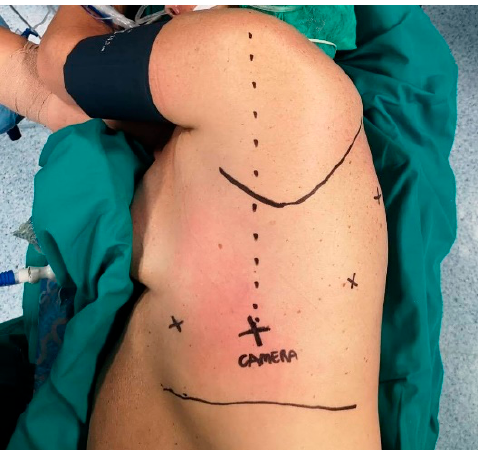
Figure 1. Standard port-mapping for totally endoscopic robotic lobectomy.